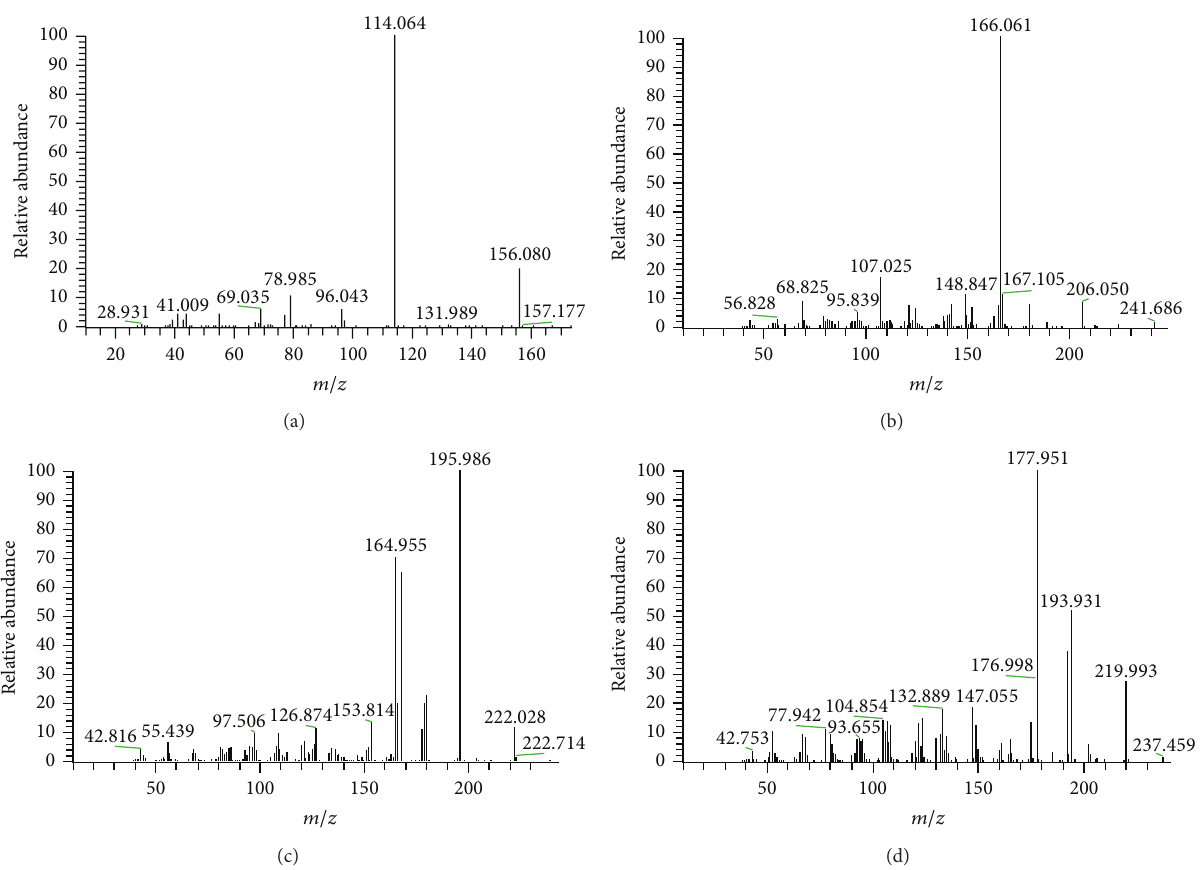
Figure1:Productionspectrafor(a)epsilon-acetamidocaproicacid(AACA,precursorion m/z 174.1),(b)tetrahydrobiopterin(BH4,precursor ion m/z 242.1), (c) dihydrobiopterin (BH2, precursor ion m/z 240.0), and (d) biopterin (precursor ion m/z